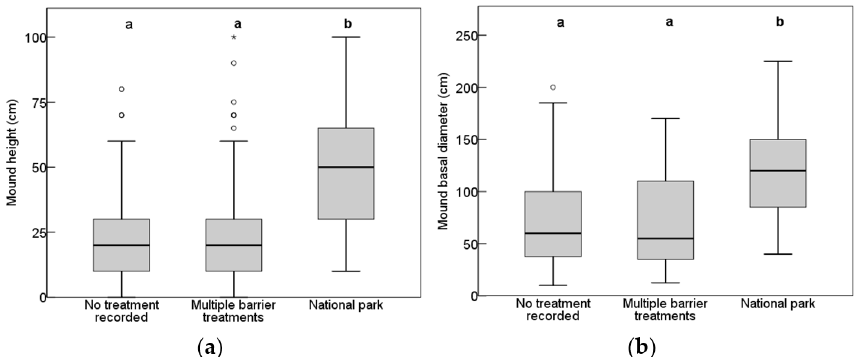
Figure 3. Boxplots of the height ( a ) and mean diameter ( b ) of occupied termitaria in unsprayed ( N = 377; no treatment recorded) and repeatedly sprayed ( N = 119; multiple barrier treatments) areas and in a national park ( N = 31). Box plots show the median, lower/upper quartile, smallest/largest observation, outliers ( ◦ ) and extreme cases (*). Means with different small letters are significantly